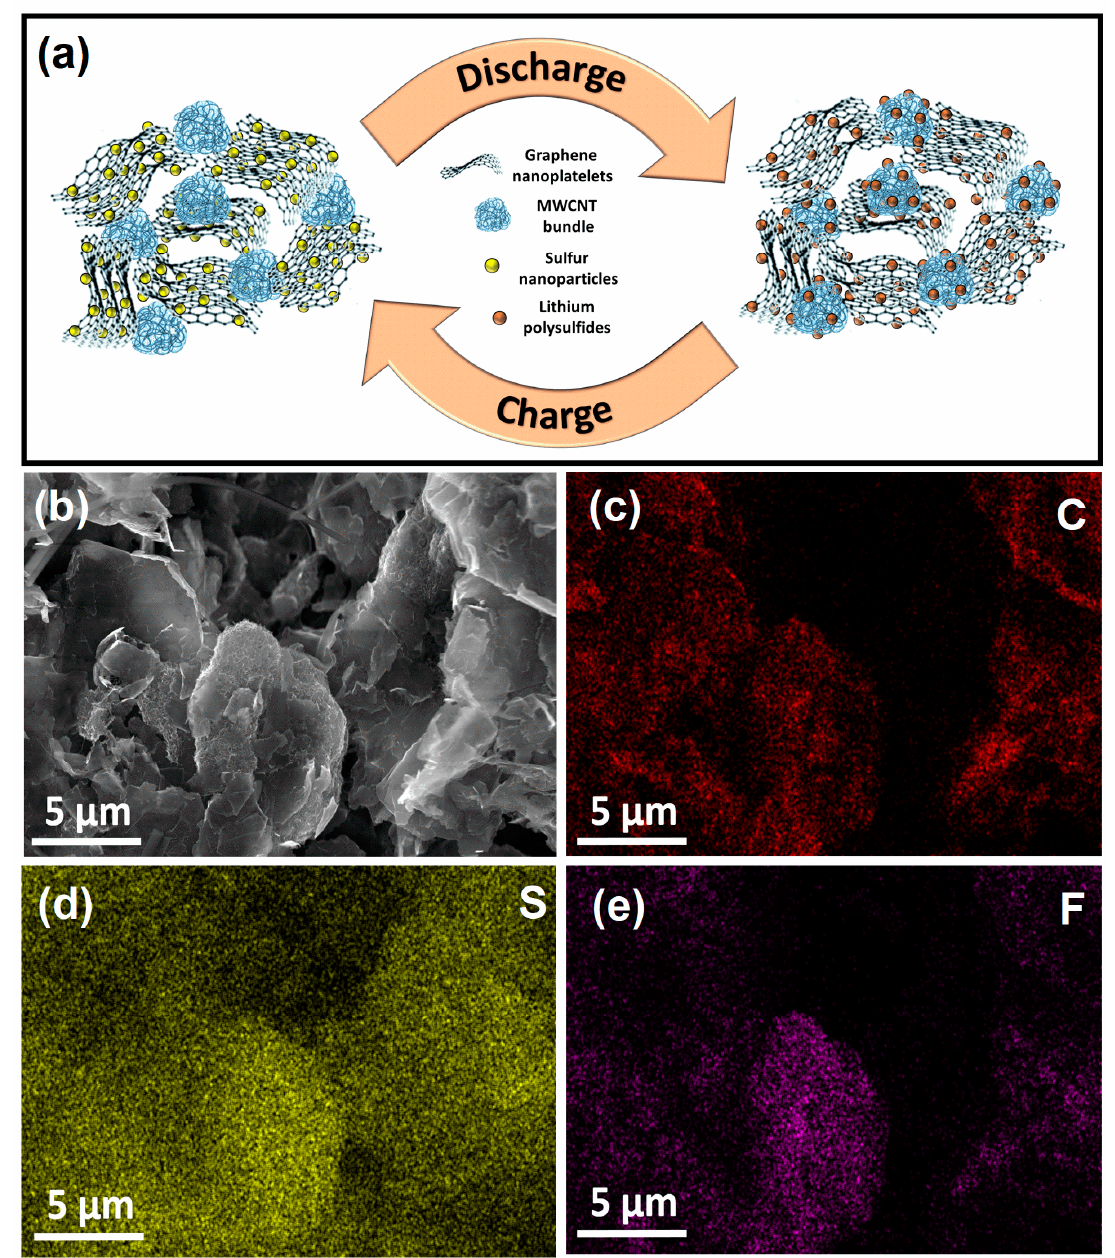
Figure 5. ( a ) Schematic representation of charge–discharge and polysulfide trapping mechanism in GNS58-CNT10 cathode. ( b ) SEM image and ( c – e ) EDX elemental mapping of cycled GNS58-CNT10 electrode.